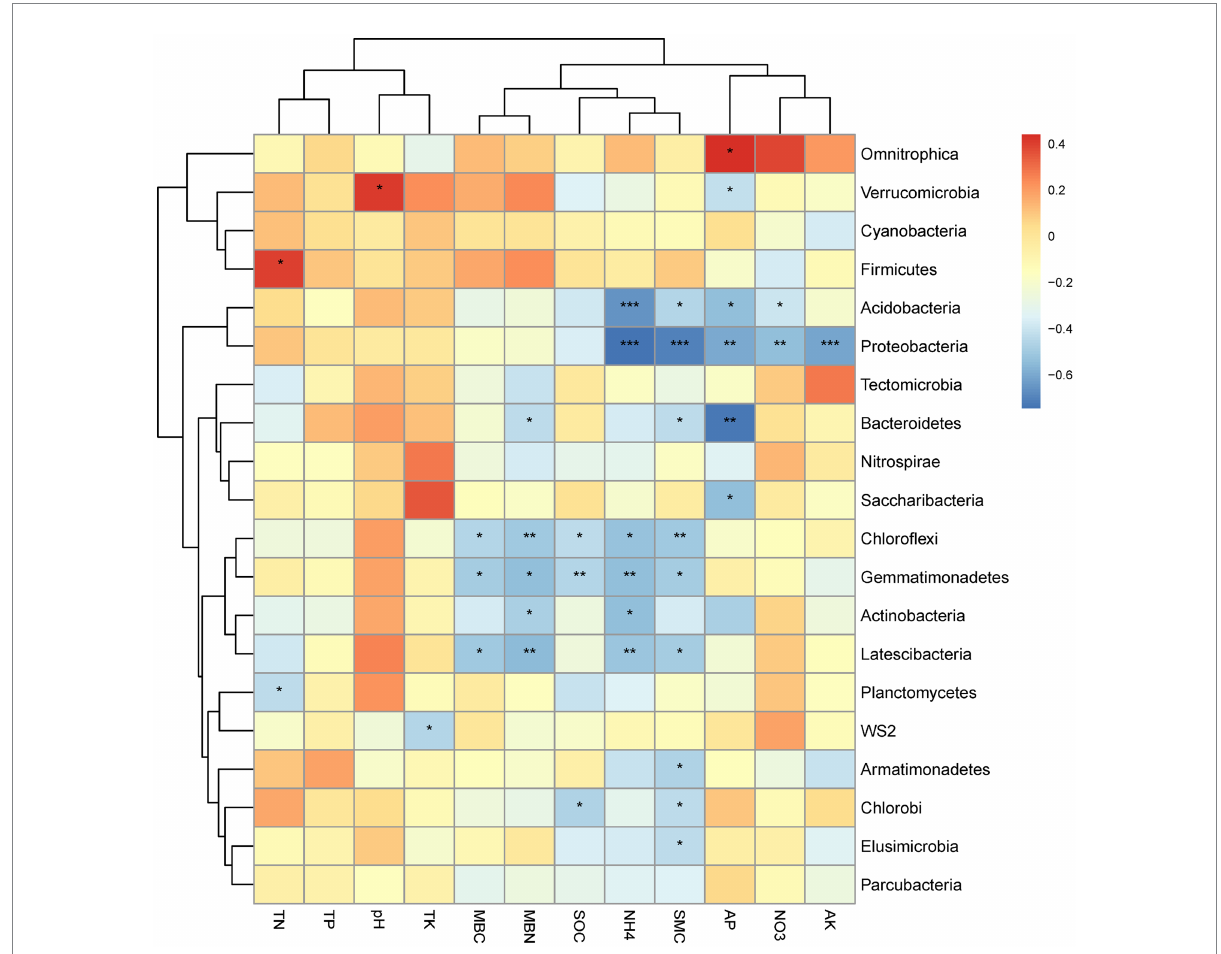
FIGURE 4 Heat map of the correlations between soil physicochemical properties and the top 20 bacterial phyla, with significance indicated as * at the 0.05 level (one-tailed) and ** at the 0.01 level (two-tailed).